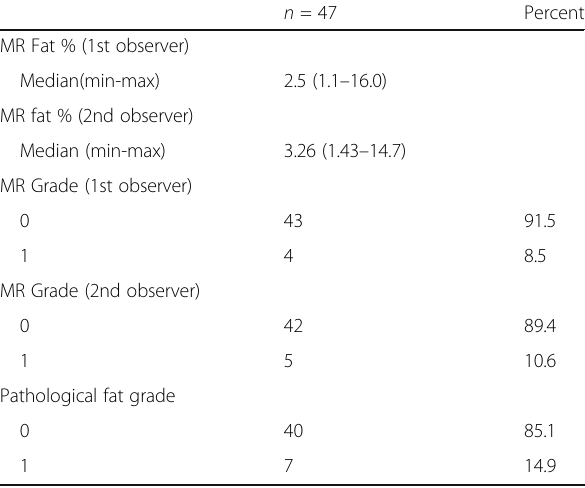
Table 2 Median and range of estimated MR and histopathological hepatic fat fractions and